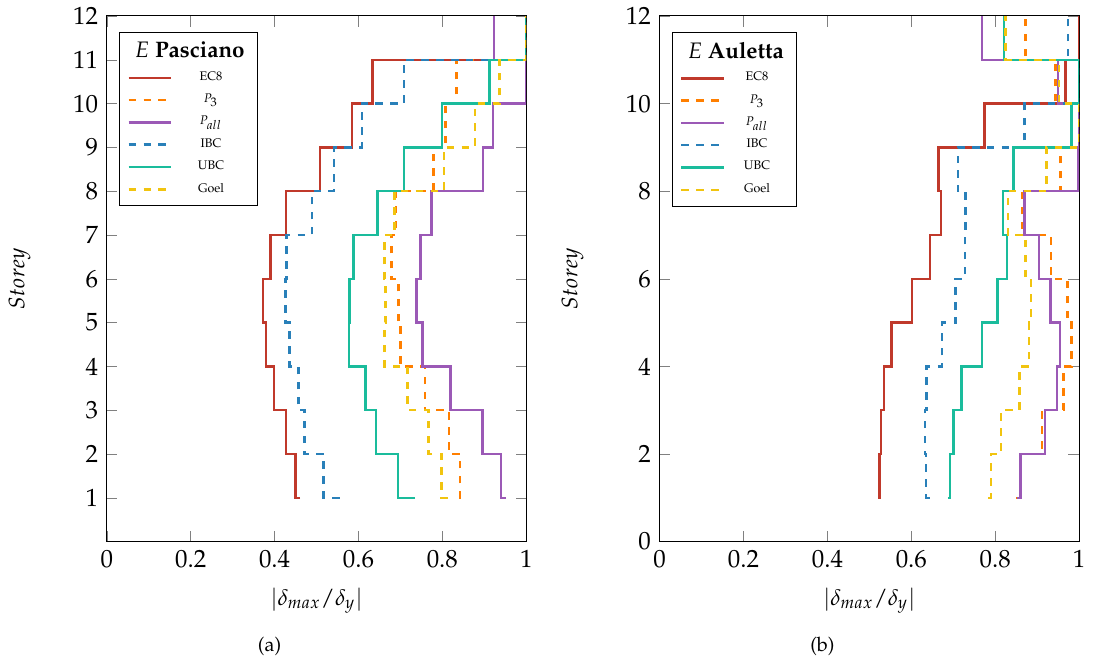
Figure 4. Maximum dimensionless inter-storey displacement distribution of the 12-storey SBM designed according to the load patterns. from dynamic time history analysis with the earthquake SOUTHERN ITALY 1980—Pasciano cimitero—HNN ( a ) and CENTRAL ITALY 2016—Auletta (Petina)—HNN ( b